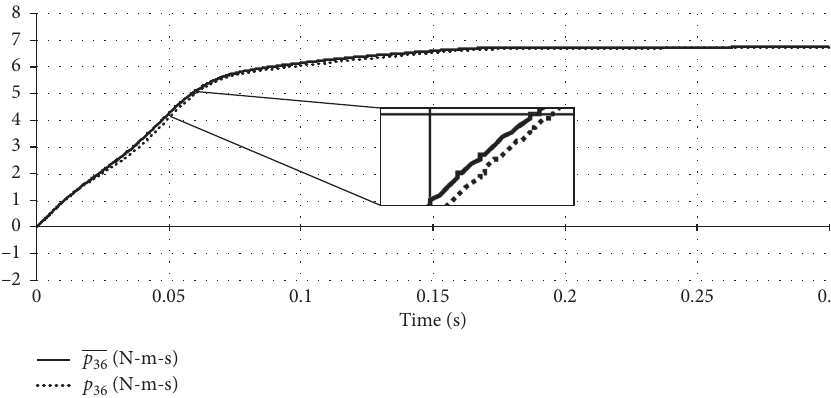
Figure 10: Performance of the slow variable p